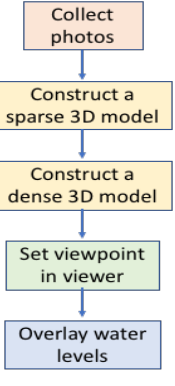
Figure 1. Workflow